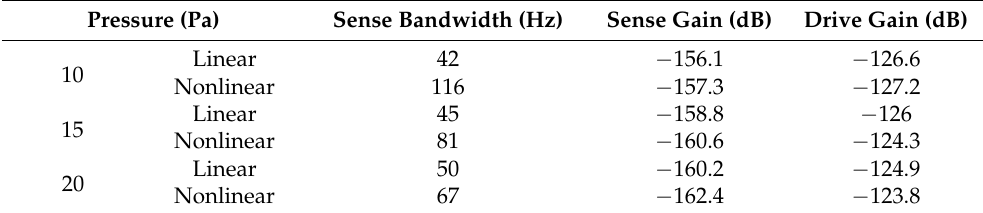
Table 5. Influence of damping on the bandwidth and gain of the drive and sense